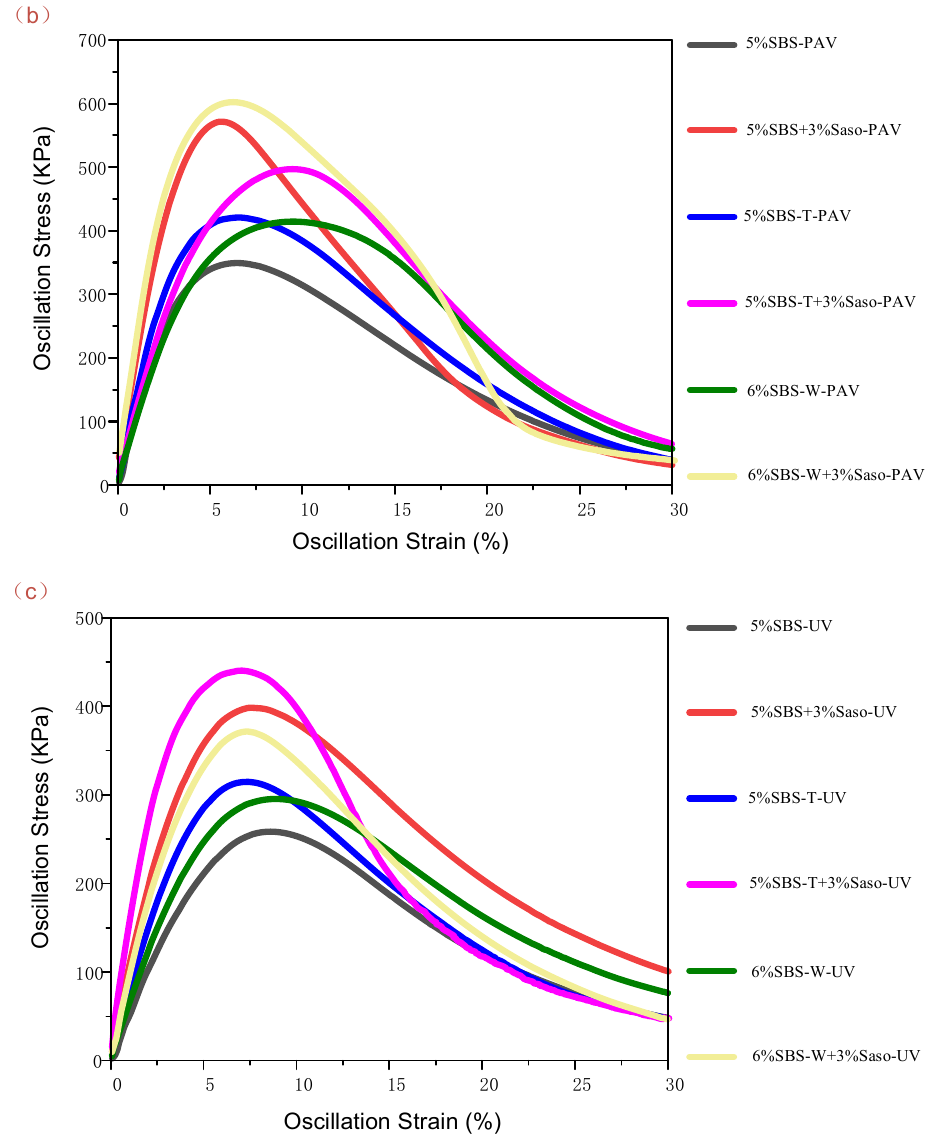
Figure 6. Stress ‐ strain curves of modified asphalt. ( a ) SBS/Saso; ( b ) SBS ‐ T/Saso; ( c ) SBS ‐